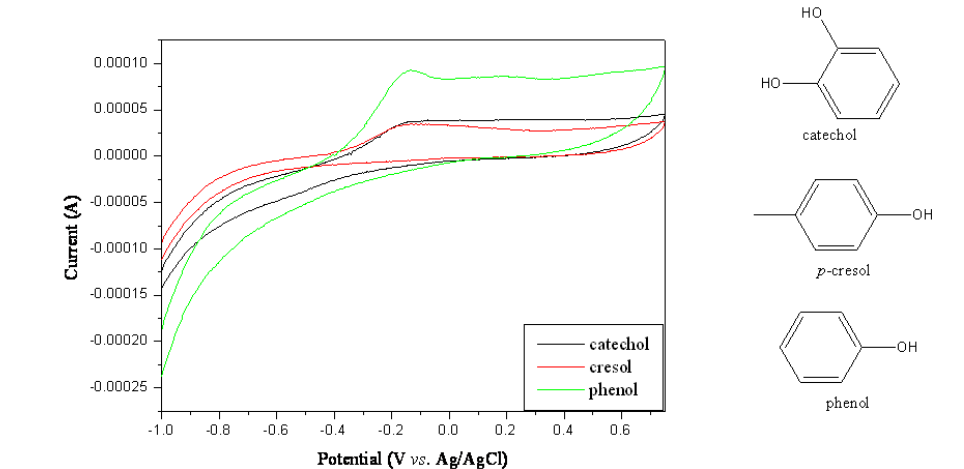
Figure 6. Cyclic voltammograms of MWNT ionic liquid electrode based on tyrosinase in 2.0 mL phosphate buffer solution (pH = 7.0) with 0.04 mM catechol, 0.04 mM p -cresol, 0.04 mM phenol.